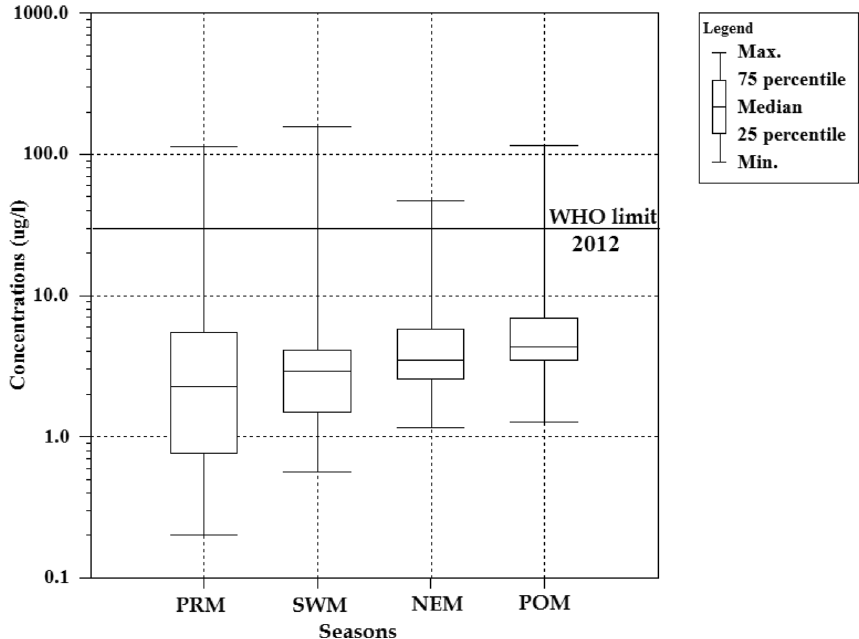
Fig. 3 Box plot exhibiting the range of U concentration in groundwater samples collected during different seasons